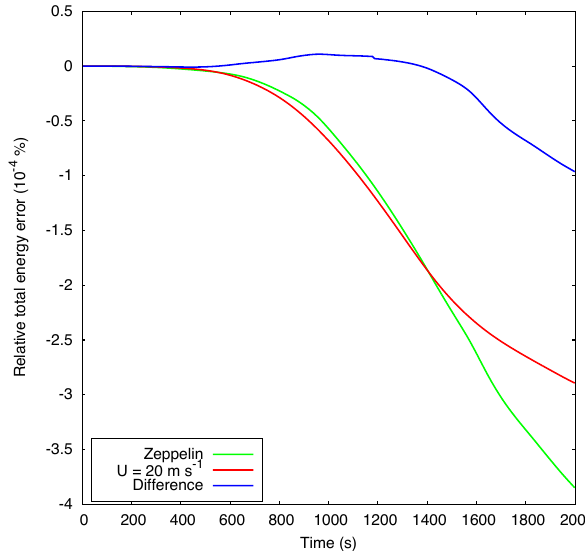
Figure 13. Same as Fig. 9, but for the zeppelin and the lateral transported moist bubble test cases. Figure 13. Same as in Fig. 9, but for the zeppelin and the lateral transported moist bubble test